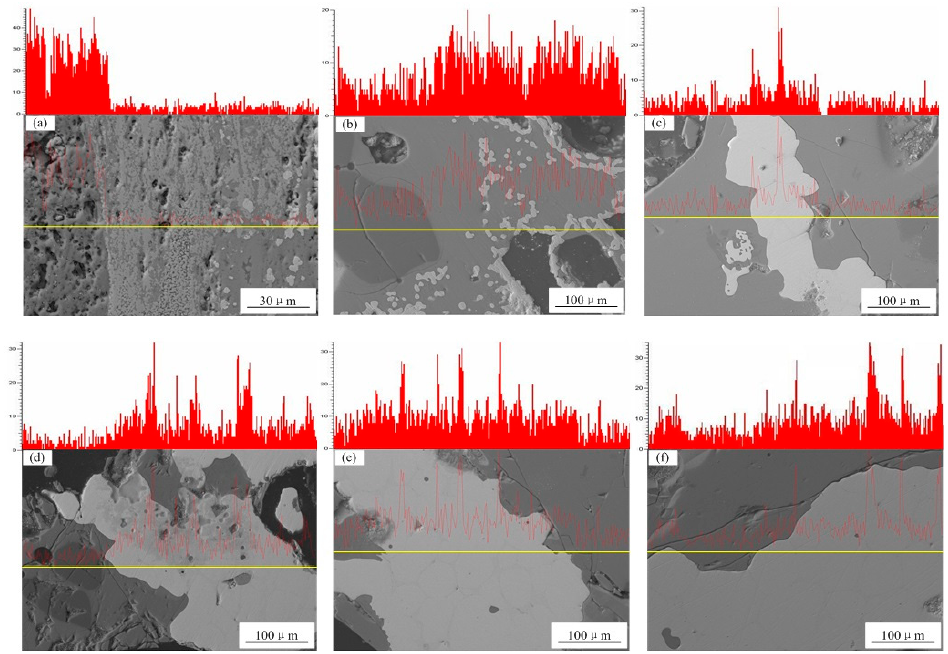
Figure 9. Line scanning analysis of P ‐ K α of ore samples after reduction for: ( a ) 10; ( b ) 20; ( c ) 30; ( d ) 40; ( e ) 50; and ( f ) 60 min.